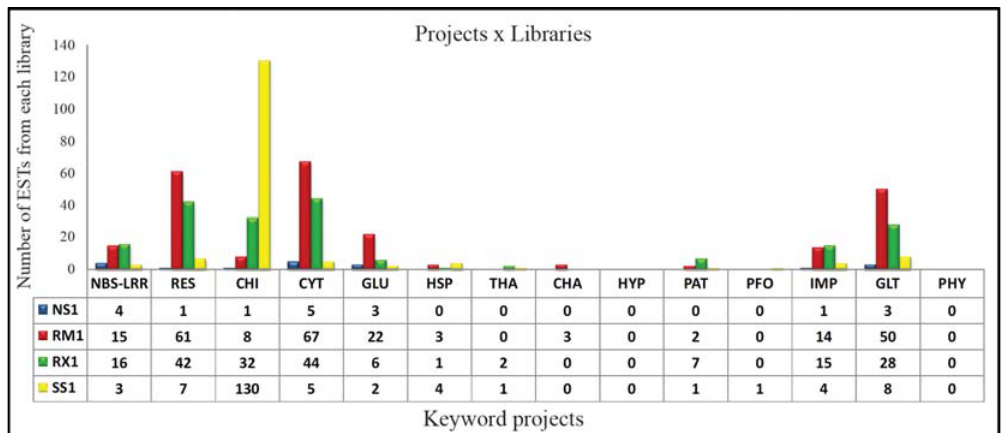
Figure 1 - Number of ESTs from NS1 (roots infected with nematodes), RM1 (leaves infected with leaf miner and coffee leaf rust), RX1 (stems infected with Xylella spp.)andSS1(well-wateredfieldplants)librariesthatwerepresentinthecreatedprojects.CHA–chalconesynthase,CHI–chitinase,CYT– cytochromeP450,GLT–glucosyltransferase,GLU–glucanase,HYP–hypersensitive,IMP–importin,NBS-LRR–nucleotidebindingsite-leucinerich repeat, PAT – pathogenesis, PFO – polyphenoloxidase, PHY – phytoalexin, RES – resistance and THA –